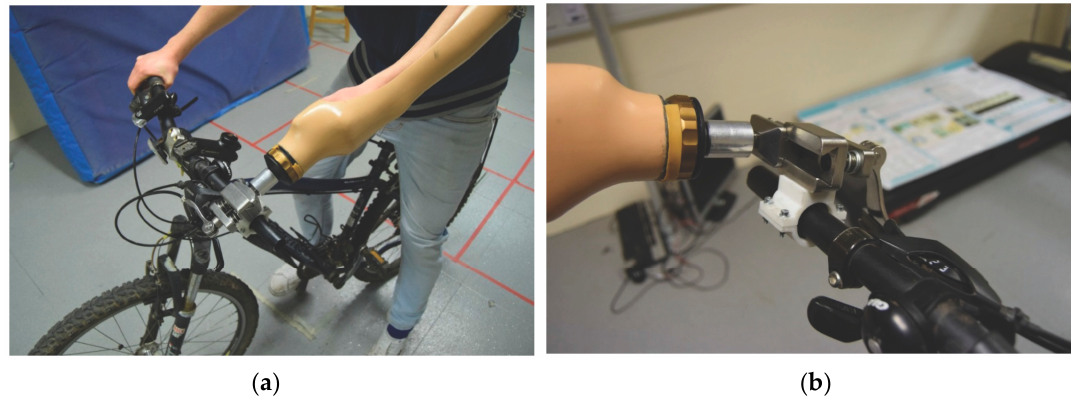
Figure 9. Practical experimentation: ( a ) Volunteer on bicycle; ( b ) Prosthetic hand release test.